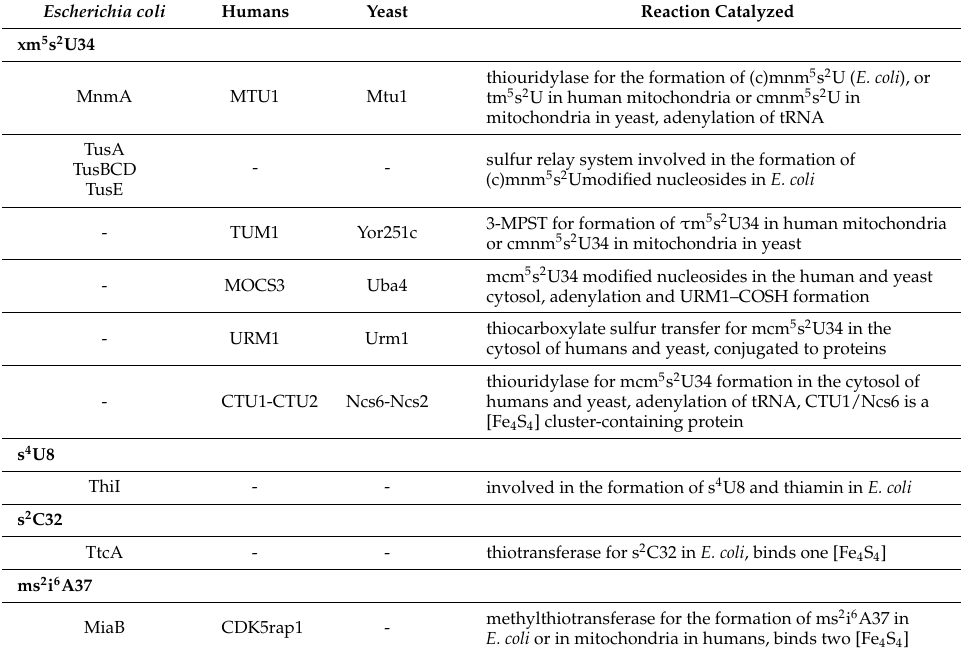
methylthiotransferase for the formation of ms 2 i 6 A37 in E. coli or in mitochondria in humans, binds two [Fe 4 S 4